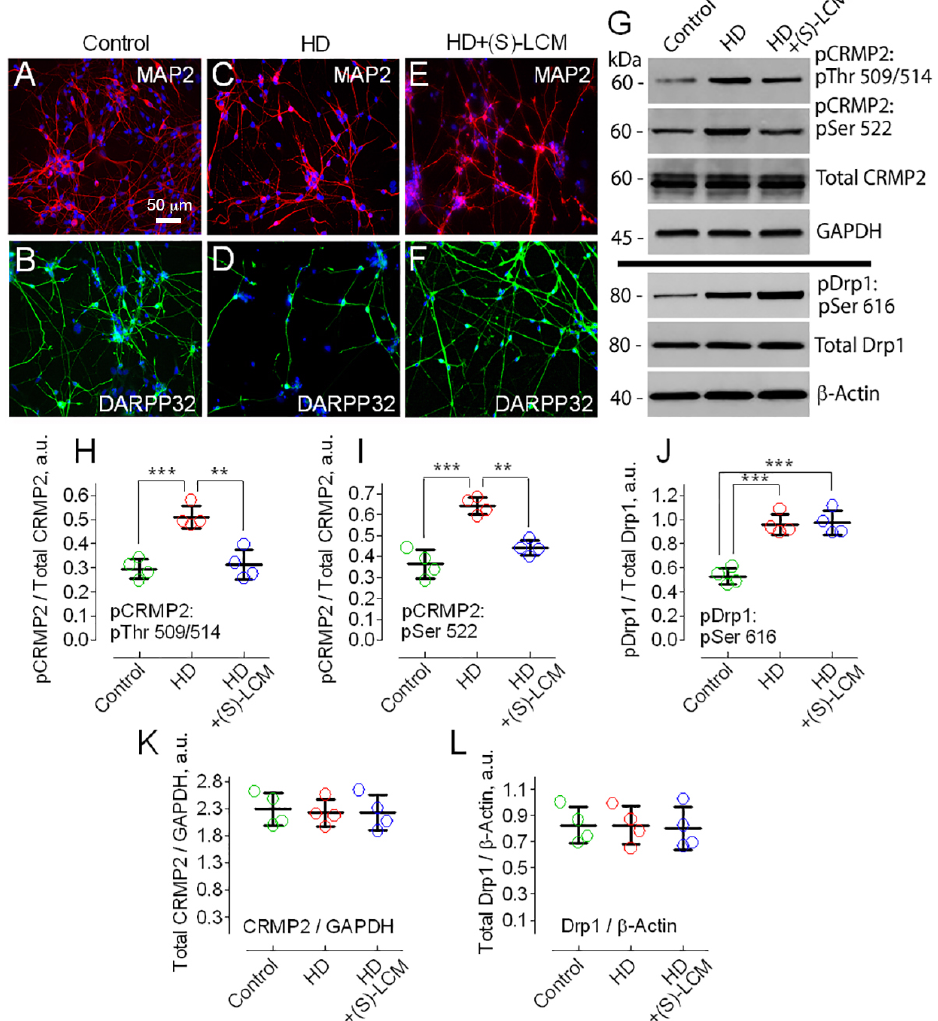
Figure 2. Increased CRMP2 and Drp1 phosphorylation in human striatal neurons derived from induced pluripotent stem cells (iPSCs) from fibroblasts of HD patients compared to striatal neurons from unaffected individuals (control). (S)-lacosamide ((S)-LCM) prevented CRMP2 hyperphosphory- lation but failed to diminish Drp1 phosphorylation in HD neurons. In these experiments, human neurons from three control cell lines (hFib2-iPS5, TiPS5, and miPS-2) and three HD cell lines (HD-iPS4, CS04iHD-46n10, and CS03iHD-53n2) were used. With neurons from miPS-2 cell line (control) and CS03iHD-53n2 cell line (HD), immunoblotting experiments were performed twice. Scale bar = 50 µ